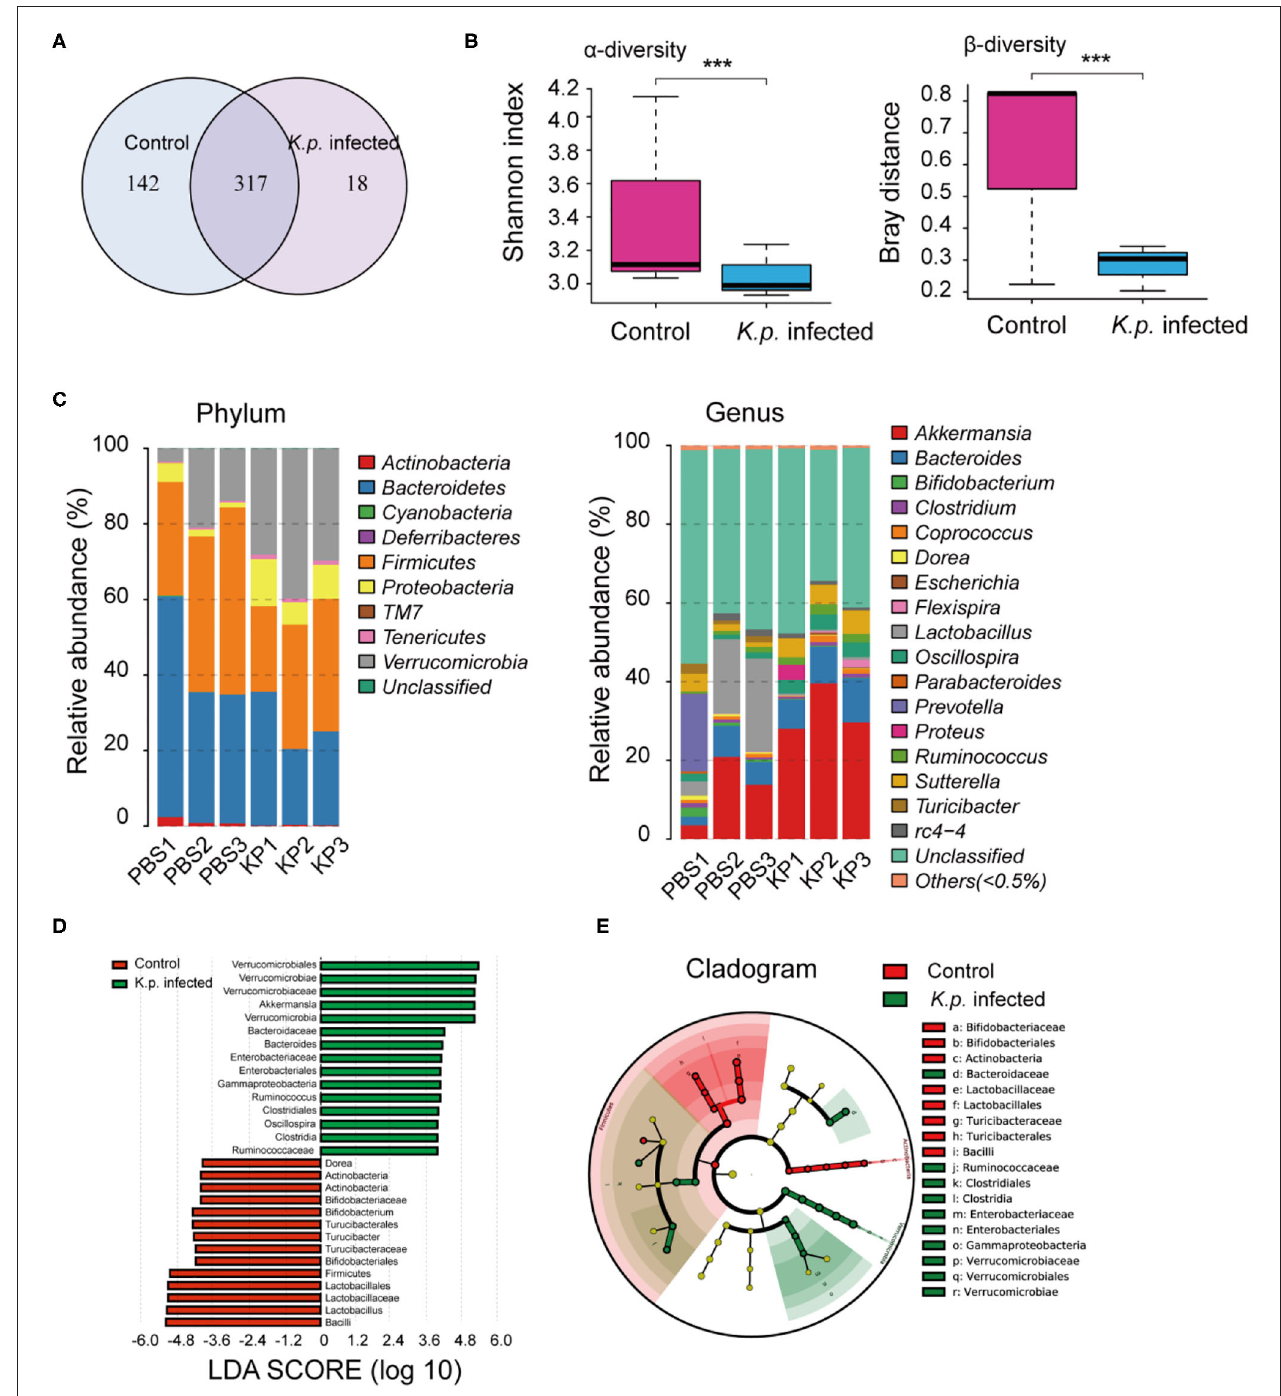
FIGURE 2 | Comparison of gut microbiome between K. pneumoniae -infected mice and healthy controls. (A) Venn diagram of operational taxonomic units (OTUs) in K. pneumoniae- infected mice and untreated controls. (B) α -diversity (Shannon index) and β -diversity (Bray–Curtis similarity index) of 16S rRNA genes from K. pneumoniae- infected mice and untreated controls. (C) Discriminative OTUs abundance of taxonomic distributions at phylum and genus levels in K. pneumoniae- infected mice compared to untreated controls. (D) LEfSe analysis shows differentially abundant genera as biomarkers between K. pneumoniae- infected mice and untreated controls. (E) Cladogram representation of the differentially abundant families and genera between K. pneumoniae- infected mice and untreated controls. Group size is 8–10 per group. P -values are determined by two-tailed Wilcoxon rank-sum test (B) and Kruskal–Wallis test (D) ( P < 0.05). *** P < 0.001.